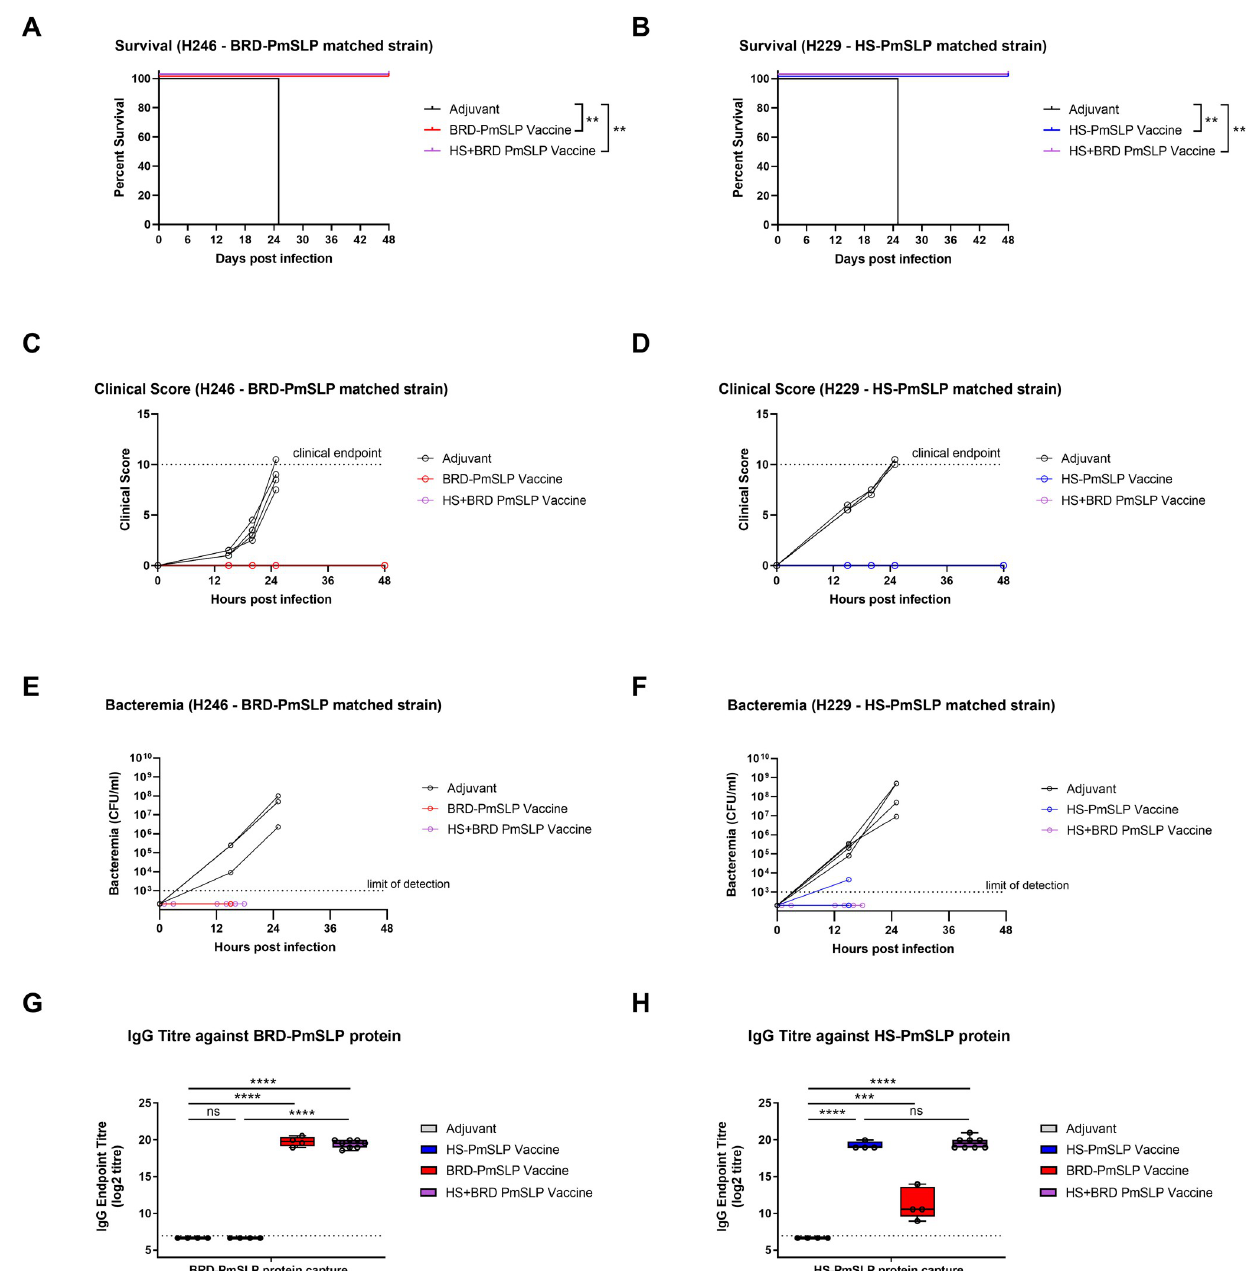
Fig 3. Evaluation of bivalent versus single component PmSLP vaccines using a murine infection model. Survival of vaccinated and control animals after challenge with the A. BRD-PmSLP antigen-matched strain H246 or B. HS-matched H229 strain. N = 4 per group. Log-rank (Mantel Cox) tests performed for survival curve comparisons; ** , p < 0.01. C, D. Cumulative clinical scores depicted for individual animals over the course of 48 hours. Dotted line at 10 indicate the clinical cut-off used for determining humane endpoint. E, F. Bacterial burden in tail bleeds depicted for individual animals over time. G, H. Serum IgG titre in vaccinated or adjuvant control animals measured using purified BRD-PmSLP or HS-PmSLP proteins as capture. Boxplot with individual animals is shown. Ordinary 1-way ANOVA with Tukey’s multiple comparisons test performed on log2 transformed data to calculate p-value. *** , p < 0.005; **** , p < 0.0001; ns, not significant.